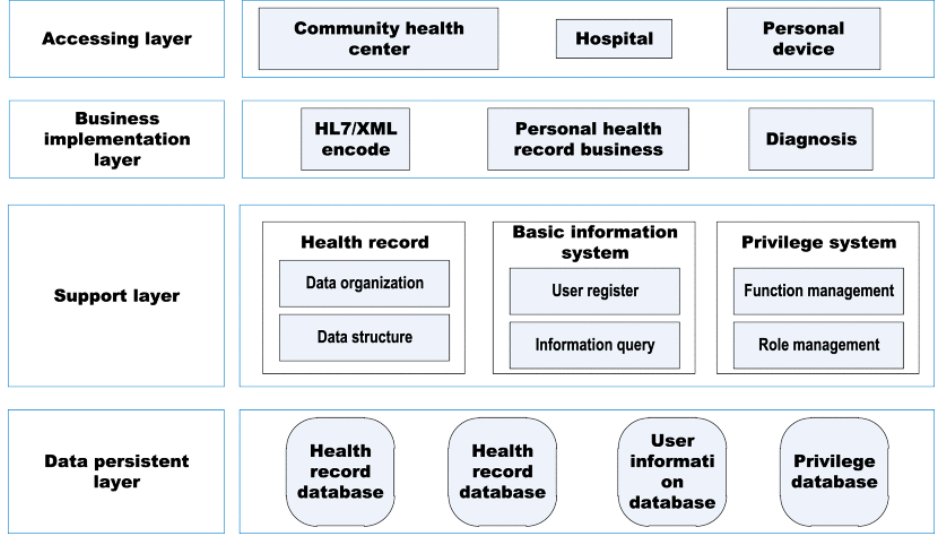
Figure 20. Health information service model’s functional framework [68].